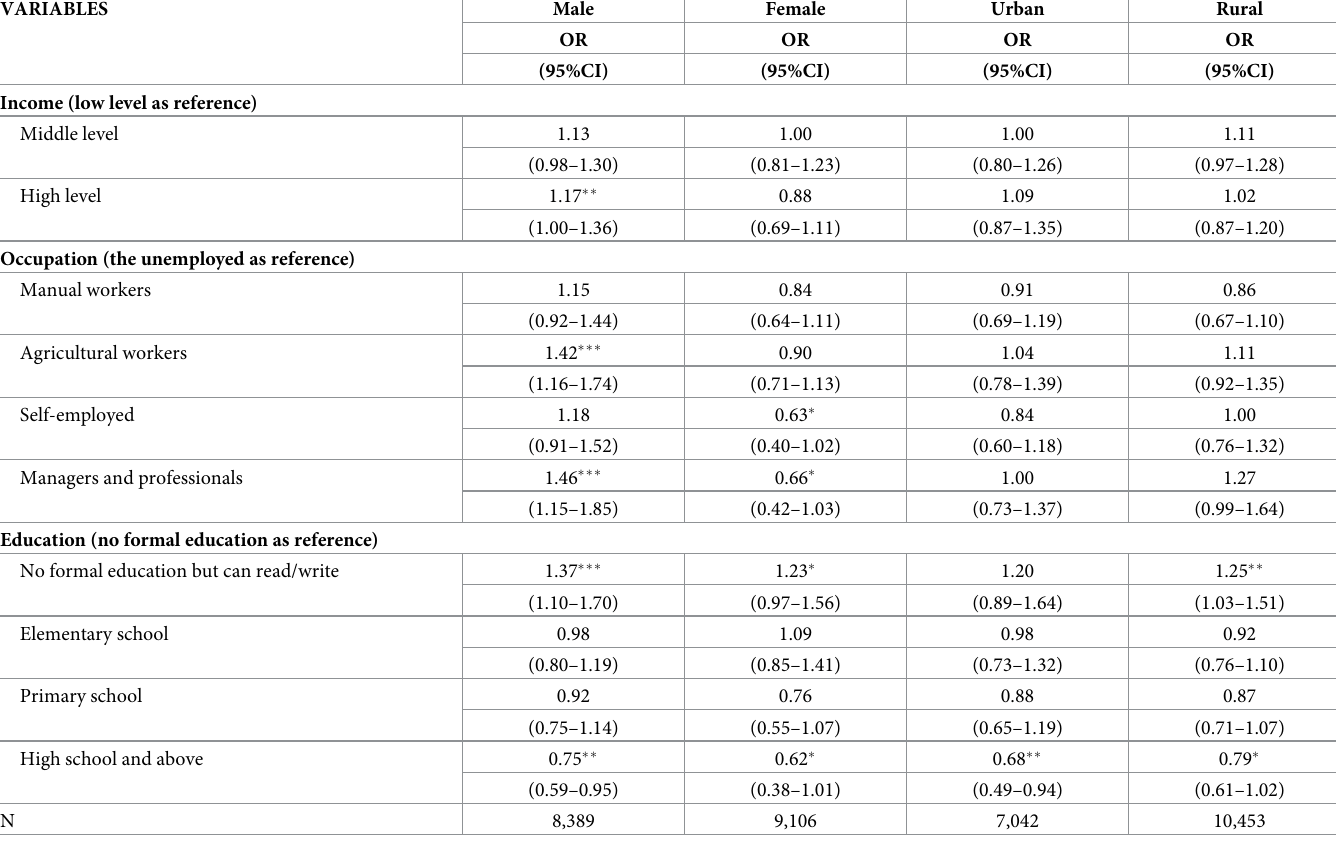
Table 2. Association between SES and smoker using Logit model (non-smoker as reference): OR with 95%